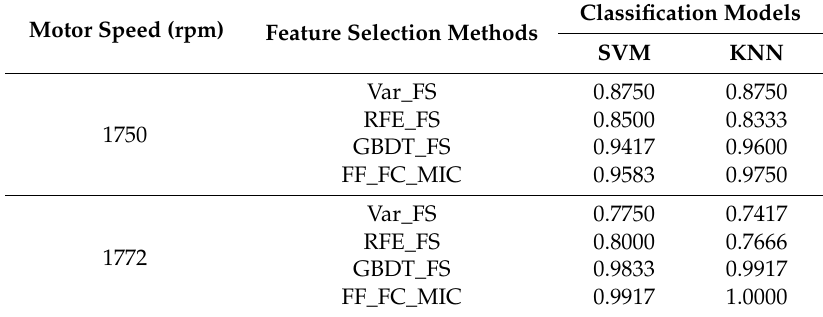
Table 4. Comparison of classification accuracy of SVM and KNN at motor speeds of 1750 rpm and 1772 rpm using different feature selection methods.